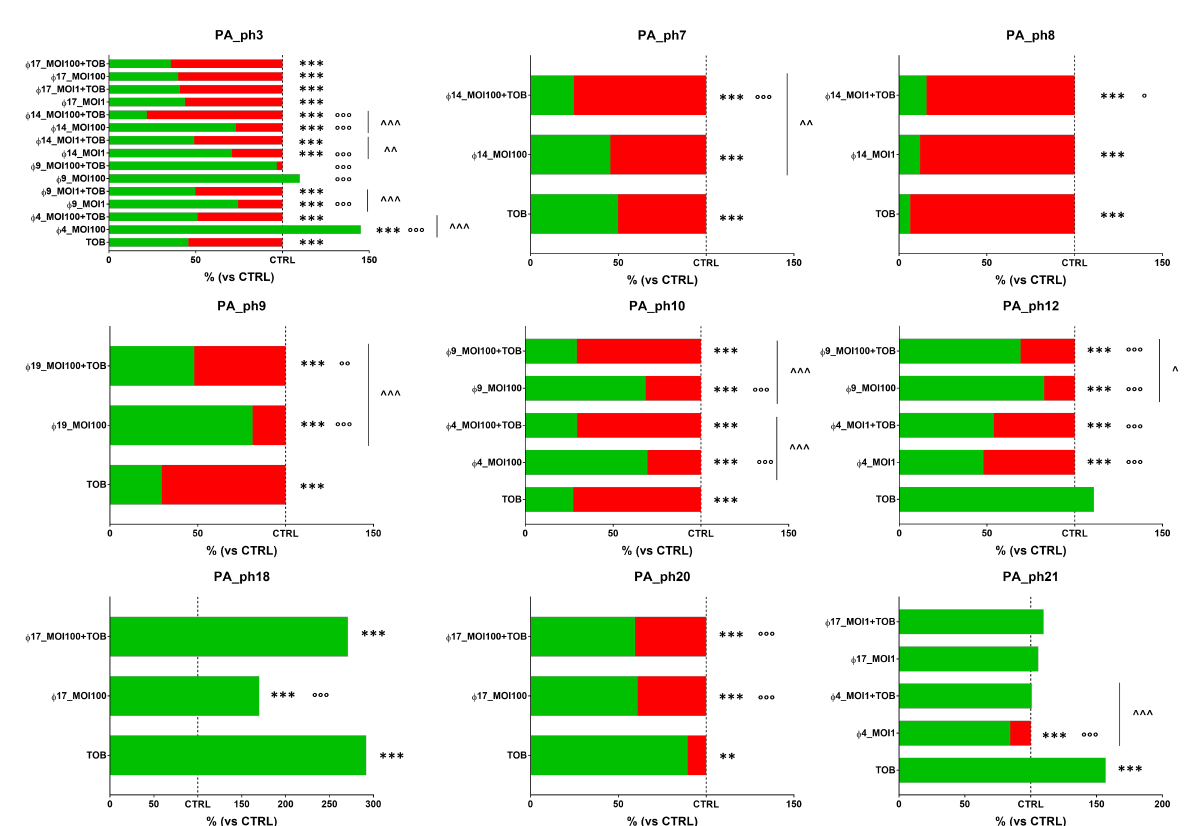
Figure 5. In vitro phage and tobramycin (TOB) activity, alone and in combination, against nine 24-h-old cystic fibrosis Pseudomonas aeruginosa (PA) biofilms. Biofilm dispersion evaluated by crystal violet stain. The results are shown as percentages in dispersed PA biofilms (highlighted in red) compared with unexposed PA control samples (CTRL) in trypticase soy broth (TSB); the dotted line indicates 100% residual biofilm after a challenge with TSB; significant levels ** p < 0.01, *** p < 0.001 each treatment vs. CTRL; ◦ p < 0.05, ◦◦ p < 0.01, ◦◦◦ p < 0.001 each treatment vs. TOB, and ˆ p < 0.05, ˆˆ p < 0.01, ˆˆˆ p < 0.001 each treatment vs. phage + TOB analyzed by the χ 2 test.